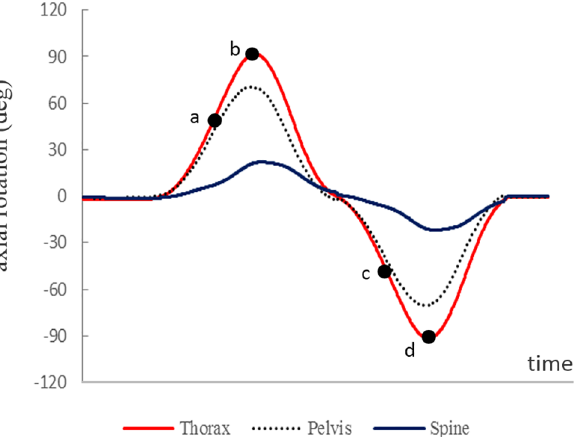
Fig 2. A representative curve of kinematic data during trunk rotation. Curves show the ROM of thorax (red line), pelvis (dotted line) and spine (blue line) in the transverse plane. The subjects performed trunk rotation task from the neutral standingposition to the left, then to the right, and returnedto neutral. The angles at 50% rotation position (a) and maximum position (b) duringleft side rotation, 50% rotation position(c) and maximum position(d) duringright side rotation were measured. The positive value represents the phase duringleft side rotation, and the negativevalue represents the phaseduringright side rotation.